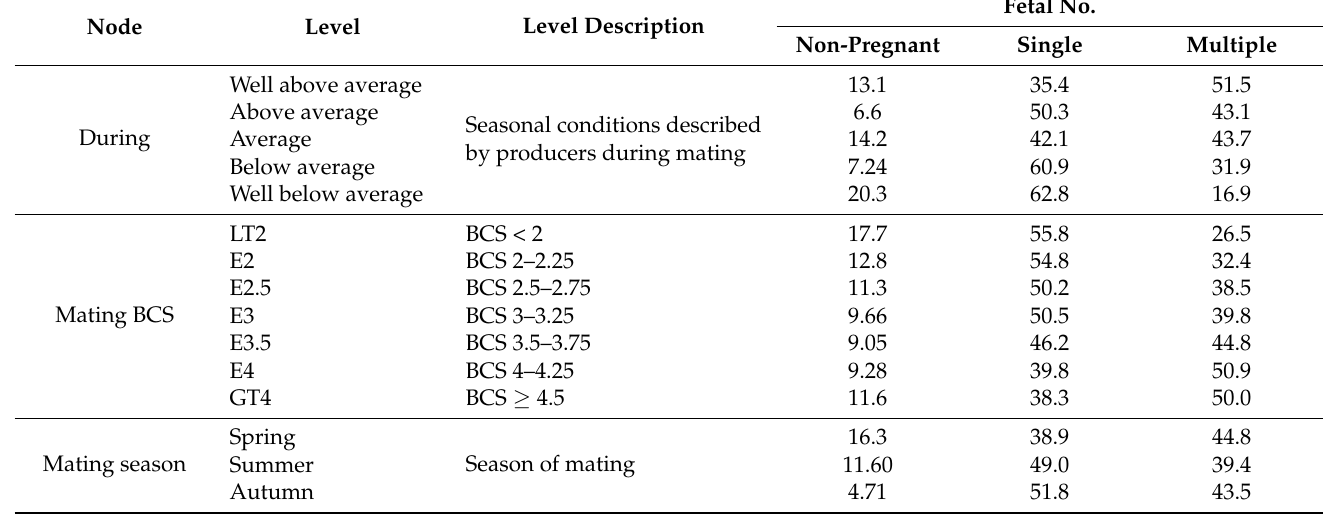
Table 6. The estimated probabilities for Merino fetal number (no., displayed as percentages) for each node (variable) when the different levels within each node are assumed in the Bayesian Network (BN) model, where BCS = body condition score. Level descriptions detail the data and naming conventions within each level of the model. A dash (-) indicates data were not applicable for the respective level. The BN model assessed the interrelationships between pregnancy outcome and fetal number of Merino ewes. Data displayed to three significant figures (rather than decimal places), as such the row total percentage value may be slightly different from 100% due to rounding errors. Letter prefixes are defined as: LT = less than, E = a range of values around the displayed value and GT = greater than. Region abbreviations are defined as: NSW = New South Wales, VIC = Victoria, QLD = Queensland and SA = South